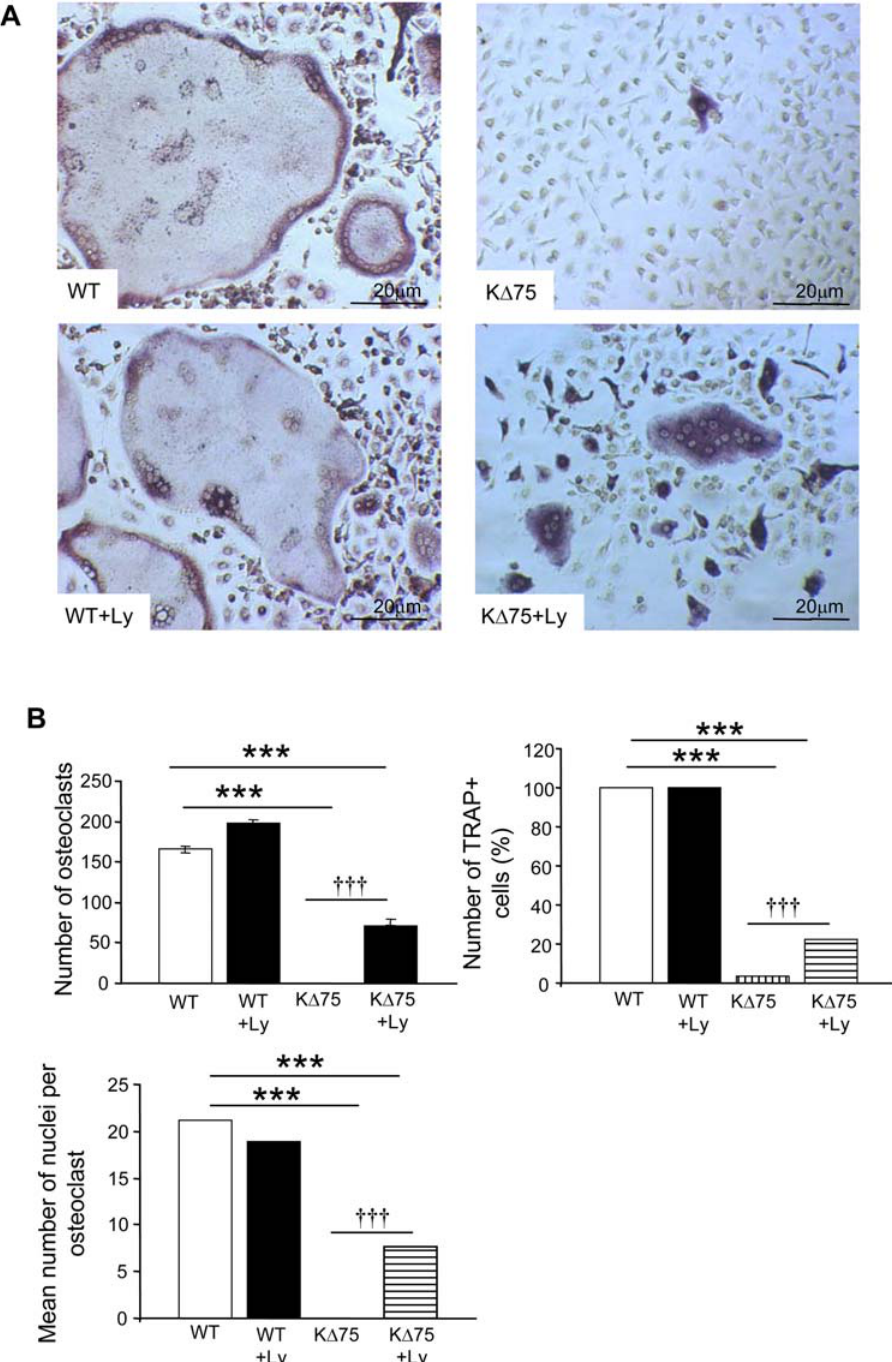
Figure 2. Lymphocytes enhance osteoclastogenesis from K D 75 but not from WT mouse spleen cells. (A) WT and K D 75 mice spleen cells were isolated using different lymphocyte separation media to collect osteoclast precursors without (upper panels) or with (lower panels) lymphocytes. Osteoclast differentiation was carried out in the presence of M-CSF and RANKL. Seven days later, cell cultures were fixed and stained for TRAP activity. Lymphocytes increased the formation of TRAP positive osteoclasts from K D 75 spleen cells (K D 75 + Ly). Pictures of representative fields from several experiments. (B) Quantification under the different culture conditions, of the number of TRAP + cells per dish; TRAP + osteoclasts with more than 3 nuclei; average number of nuclei per multinucleated osteoclast. These figures are representative of three different experiments. (* p , 0.01, ** p , 0.001, *** or {{{ p , 0.0001)